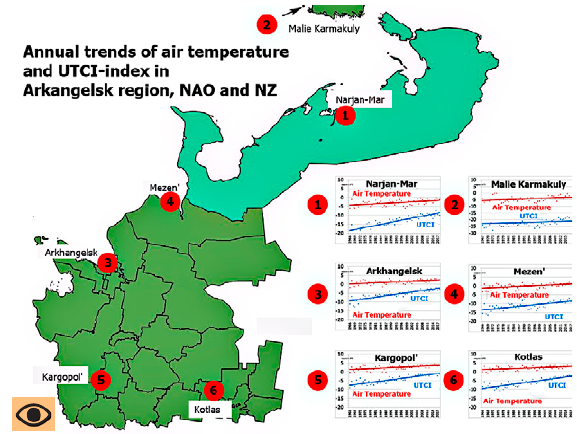
Figure 7. Spatial variability of 2m air temperature trends (annual means) and UTCI-trends (annual means) for Arkhangelsk province, NAO and NZ archipelago (far north). Trends were calculated based on data on WMO- stations for 1966-2018